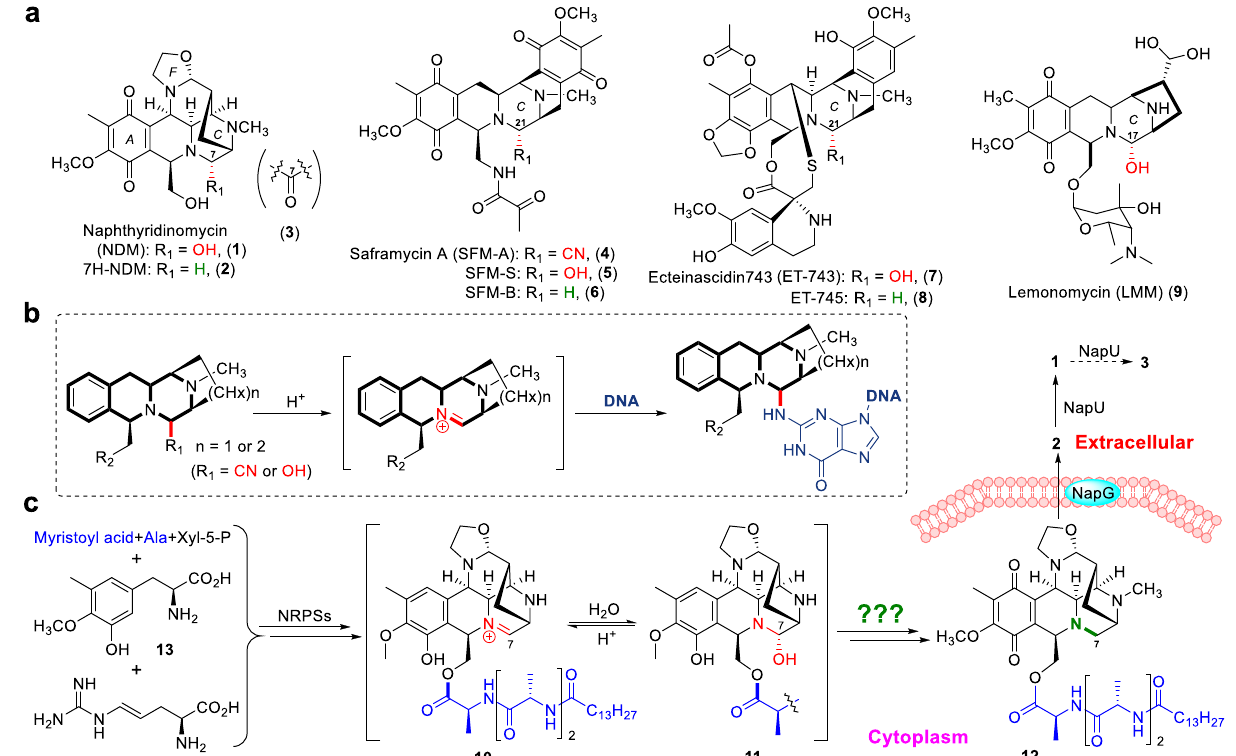
Fig. 1 Members of THIQ antibiotics, biosynthesis, and activation of NDM. a Chemical structures of typical THIQ antibiotics. b Proposed mechanism of THIQ antibiotic-mediated DNA alkylation. c Brief summary of NDM biosynthetic pathway featuring with intracellular pharmacophore quenching and extracellular